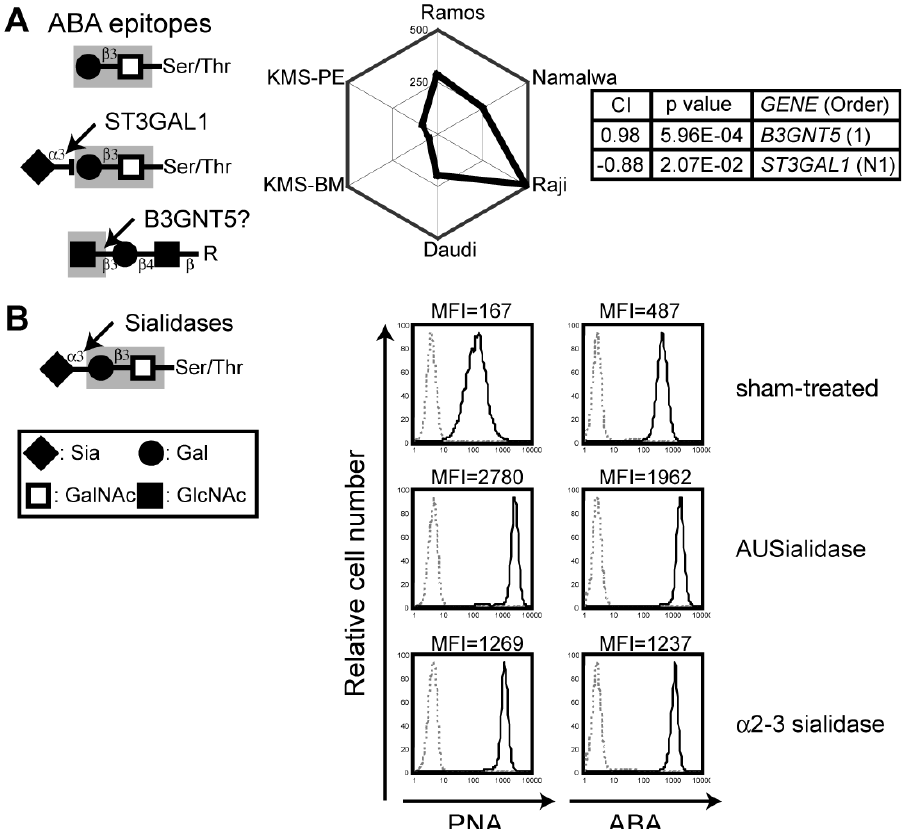
Figure 6. CIRES analyses of staining profiles obtained using the lectin ABA. (A) Presentation is the same as in Fig. 2 except that ABA was used. (B) Effect of sialidase treatment on the binding of ABA and PNA in B cells. (See text for the specificity of the sialidase and Fig. 2D for the PNA epitope.) Mean fluorescence intensity (MFI) values for the staining with each lectin (bold lines) are shown at the top. Dashed lines indicate the results from the non-staining control.